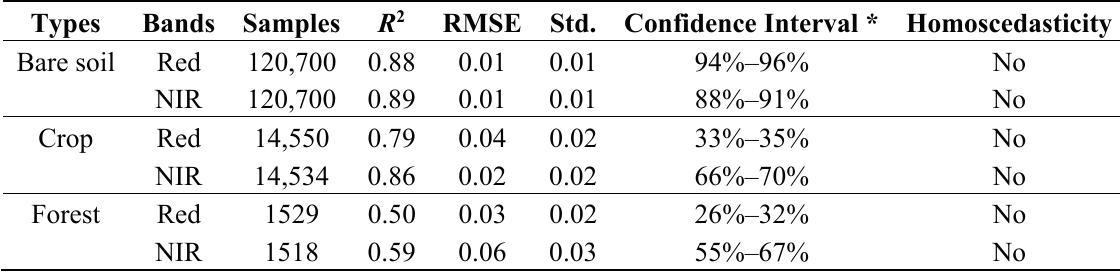
Figure 8. Density scatter plot of the reflectance in red and NIR bands between the HJ1/CCD and Landsat8/OLI dataset for bare soil ( a ), crop ( b ) and forest ( c ) on the 186th day. Table 4. Statistics of the performance of reflectance comparison both in red and NIR band between the HJ1/CCD and Landsat8/OLI dataset. ( * The confidence interval presents the true ratio of population variance, and the confidence level is